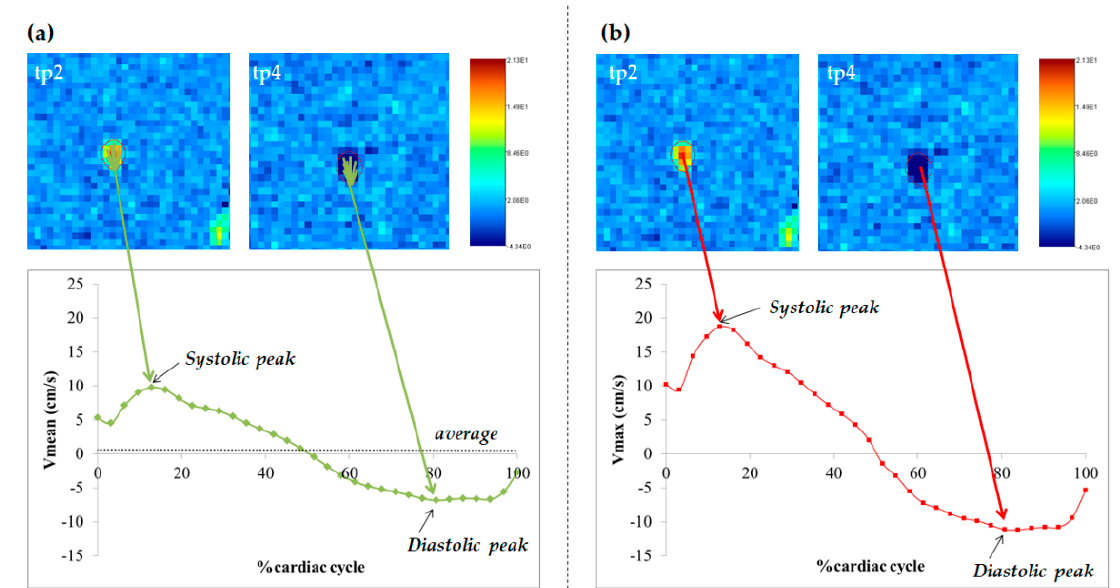
Figure 2. Aqueduct of Sylvius (AoS) cerebrospinal fluid (CSF) velocity parameters of interest. Phase images corresponding to the time points (tp) tp2 and tp4 of Figure 1, representing the systolic and diastolic peaks, are shown in the upper part of ( a ) and ( b ). In ( a ), for each time point, the velocities of all the pixels inside the segmented AoS are averaged (Vmean). The Vmean time course over the normalized [28] cardiac cycle is shown at the bottom. In ( b ), the pixel with the highest velocity (Vmax) is selected for each tp, and its time course over the normalized cardiac cycle is shown at the bottom. The parameters of interest used in our statistical analyses are written in italic.